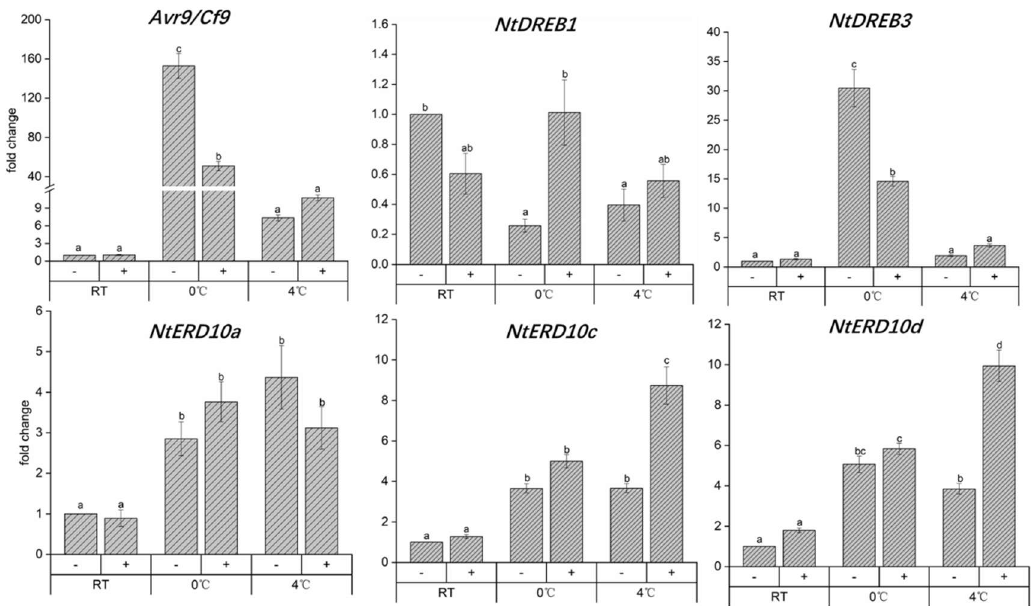
Figure 5. Effect of the nuclear import inhibitor GTP-γ-S on the cold responses of CBF and COR transcripts in the VvCBF4 overexpressor line, measured by quantitative real-time PCR analysis for endogenous CBF and COR genes in response to chilling (4 °C) and freezing (0 °C). Cells were pre- treated with 500 μM GTP-γ-S for 30 min at 25 °C prior to cold stress (0 °C or 4 °C) for an additional 24 h and then examined for gene expression. Controls (-) were treated in the same way, with the omission of GTP-γ-S, while + represents the actual test where cells were treated with GTP-γ-S. Data represent means ± SE from three independent experiments conducted in technical triplicates and are normalised to the untreated control. Different letters indicate the statistically significant difference based on an LSD test ( p < 0.01).